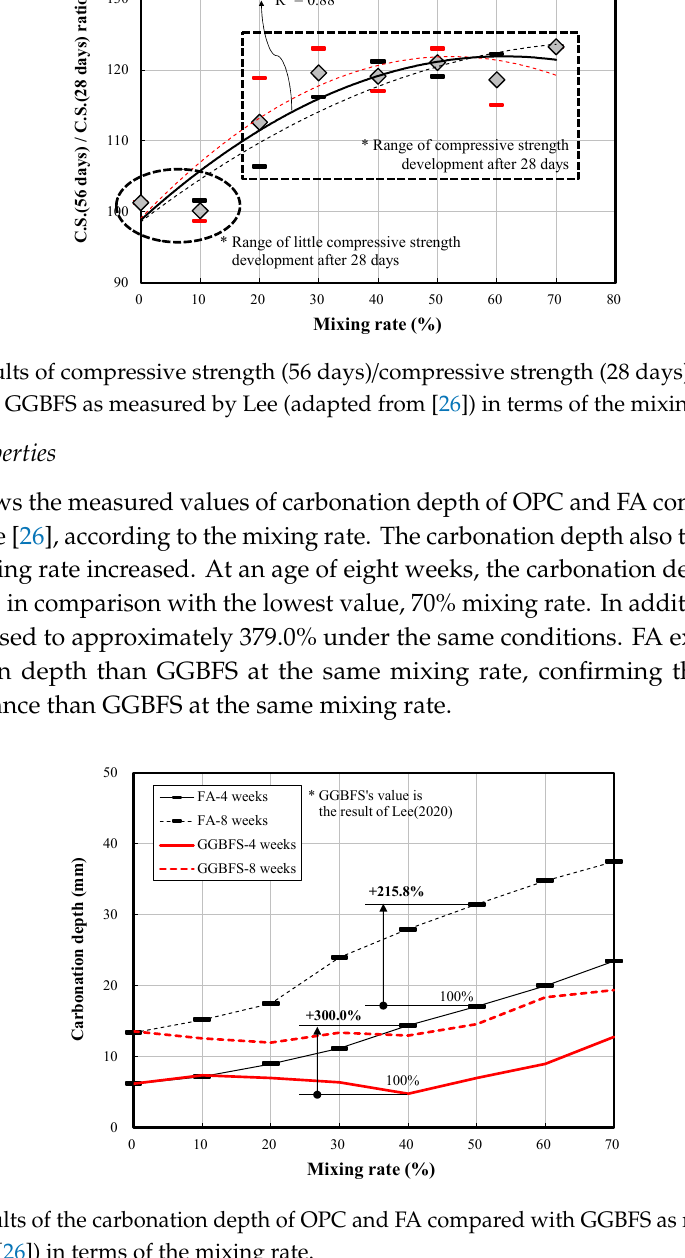
Figure 11. Results of the carbonation depth of OPC and FA compared with GGBFS as measured by Lee (adapted from [26]) in terms of the mixing rate.